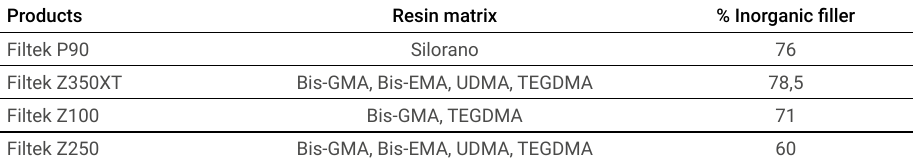
Table 1. Resin composite used in this study with respective matrix and inorganic filler